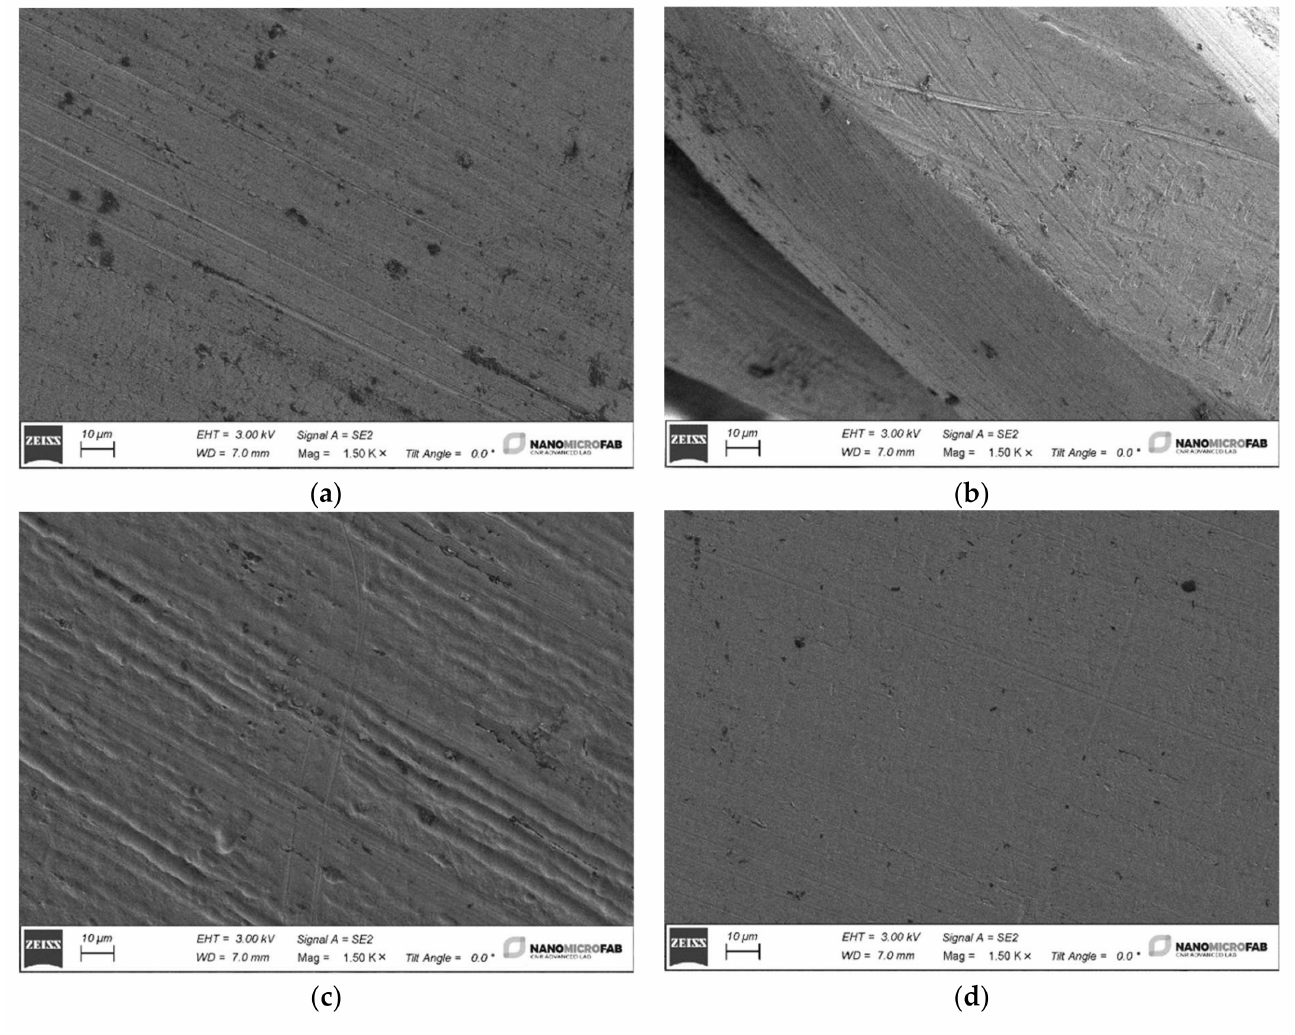
Figure 3. Four SEM images of the different “as is” samples at a magnification of 1500 × : ( a ) SS AISI 304 Extra-hard; ( b ) SS AISI 302 Twist; ( c ) Ni–Ti; ( d ) SS AISI 304